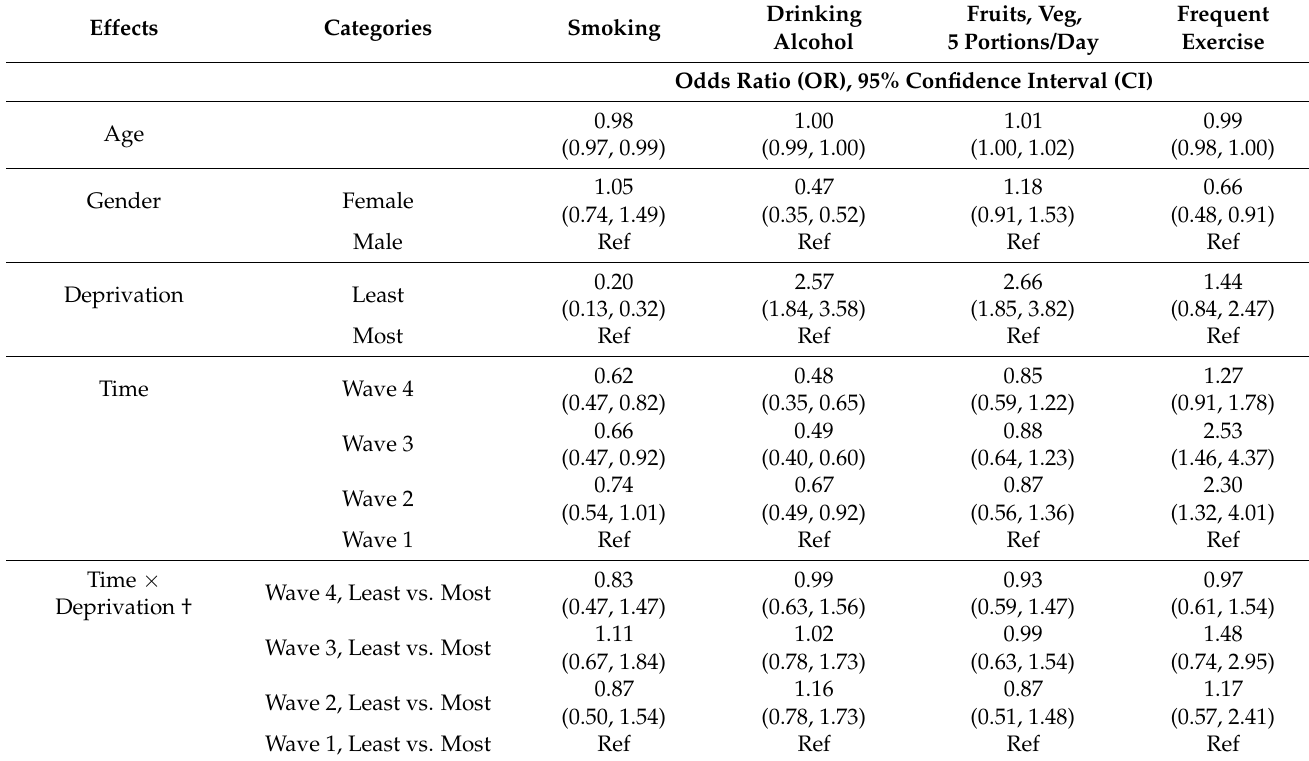
Table 4. Analysis of behaviour outcomes by time and